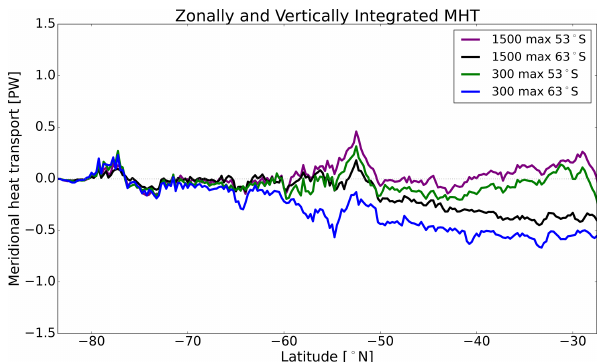
Figure 4. Zonally and vertically integrated meridional heat trans- port (MHT; in PW) for 300_max_53 ◦ S (green), 1500_max_53 ◦ S (purple), 300_max_63 ◦ S (blue) and 1500_max_63 ◦ S (black). Note that the domain north of 27.5 ◦ S is manually removed to avoid the impact of the restoring near the northern